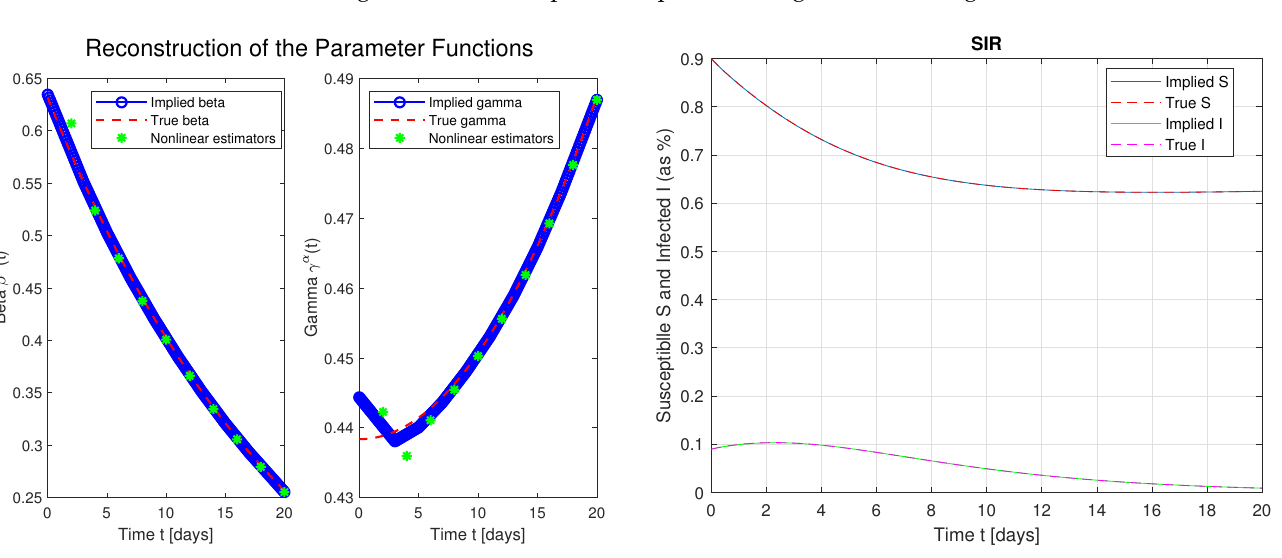
Figure 6. Recovered parameters β α ( t ) and γ α ( t ) with (12) ( left ); recovered susceptible S and infected I population with (12) ( right ).